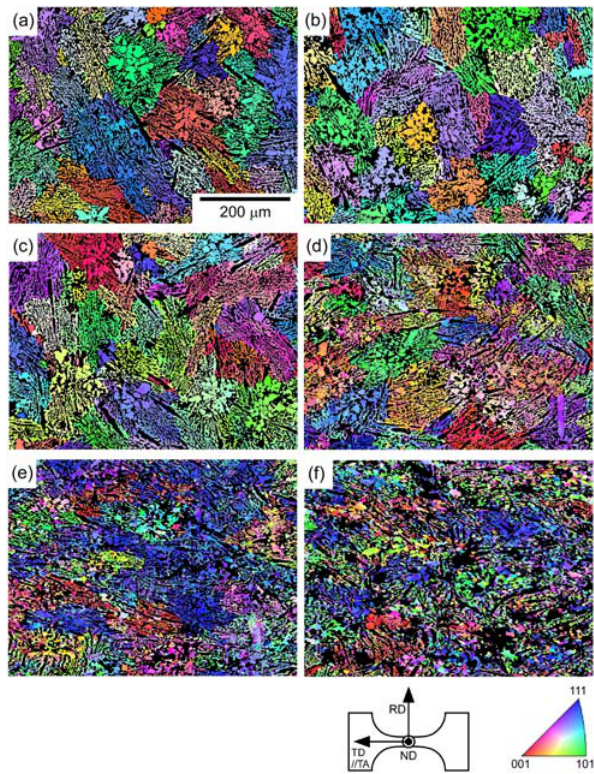
Figure 5: IPF maps of Mo ss in the MoSiBTiC alloy crept at 1,500°C and 137 MPa with creep stains of ( a ) 0%, ( b ) 3%, ( c ) 12%, ( d ) 32%, ( e ) 53%, and ( f ) 72%. The IPF maps are displayed as the orientation parallel to the normal